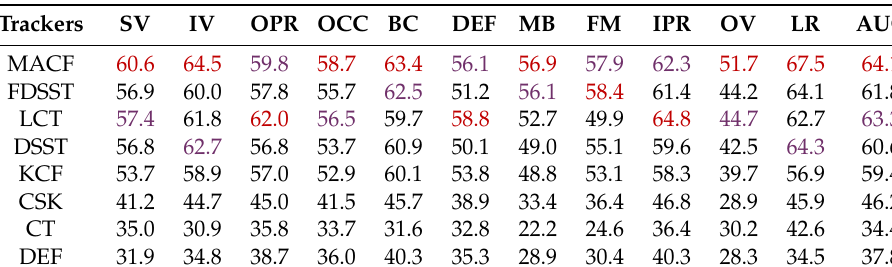
Table 5. Success plots of Spatial Robustness Evaluation (SRE) for the MACF and the other 7 top trackers on different attributes: SV, IV, OPR, OCC, BC, DEF, MB, FM, IPR, OV, and LR. The last column is the AUC. The best results are in red and the second results are in blue.